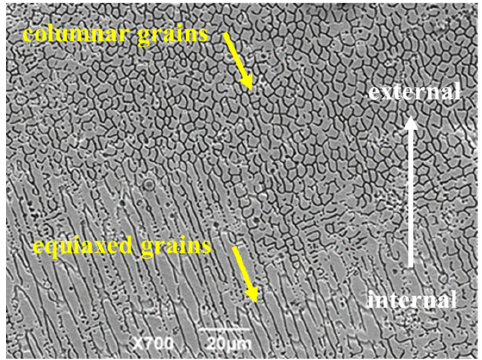
Figure 1. Microstructure of the cross ‐ sectional FeCoNiCrCu coating prepared by laser cladding [31].